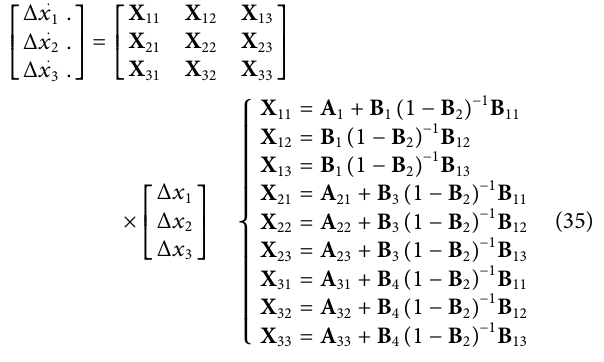
Figure 9 is the closed-loop pole distribution diagram of Eq. 35 when different PI parameters are selected (the black arrow indicates the increasing direction of the parameters